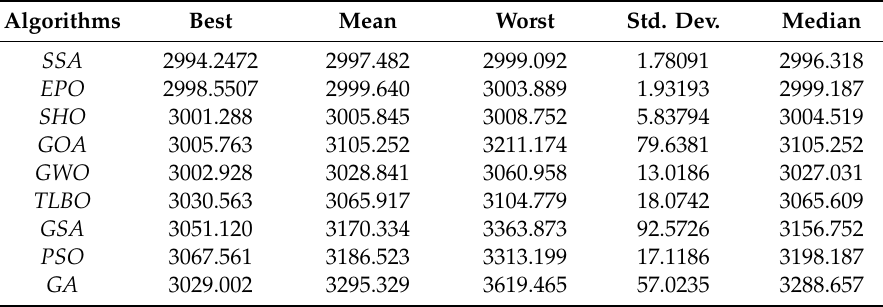
Table 8. Statistical results for speed reducer design problem.